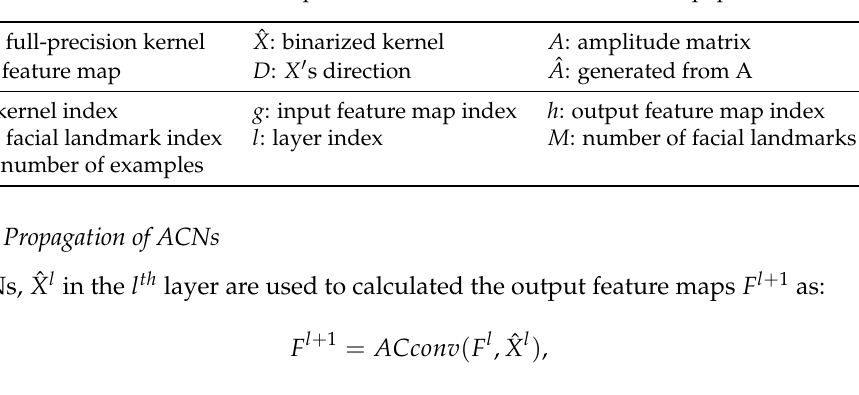
Table 1. A brief description of the main notations used in the